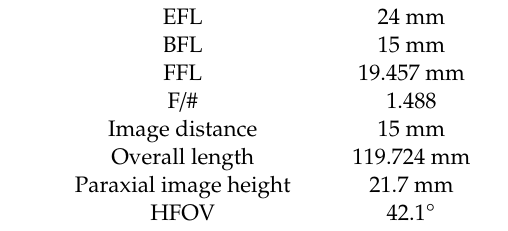
Figure 7. Optical path diagram of basic design data.